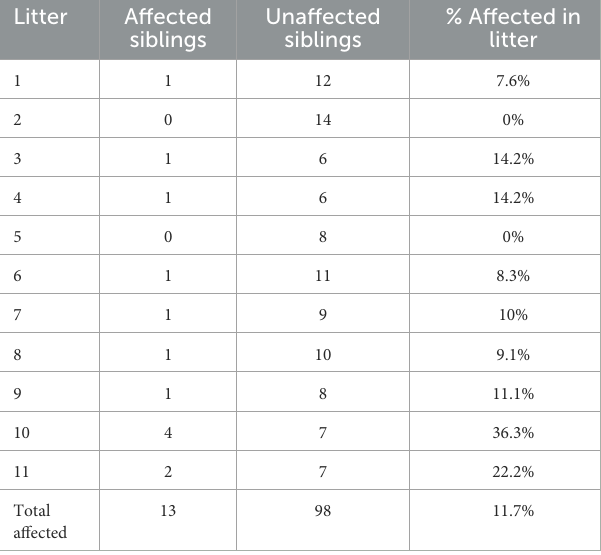
TABLE 4 Segregation analysis of the studied affected